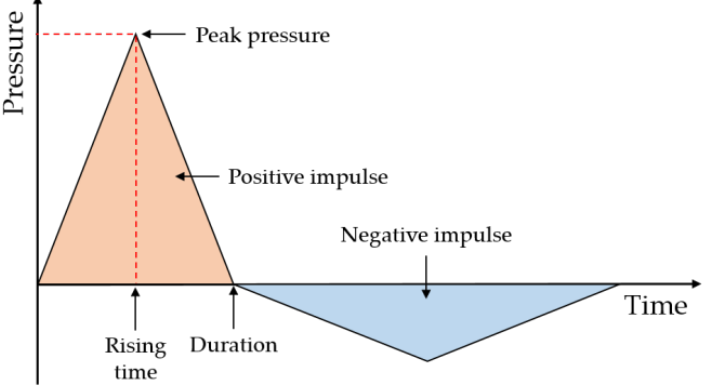
Figure 1. An idealized pressure model of gas explosion .